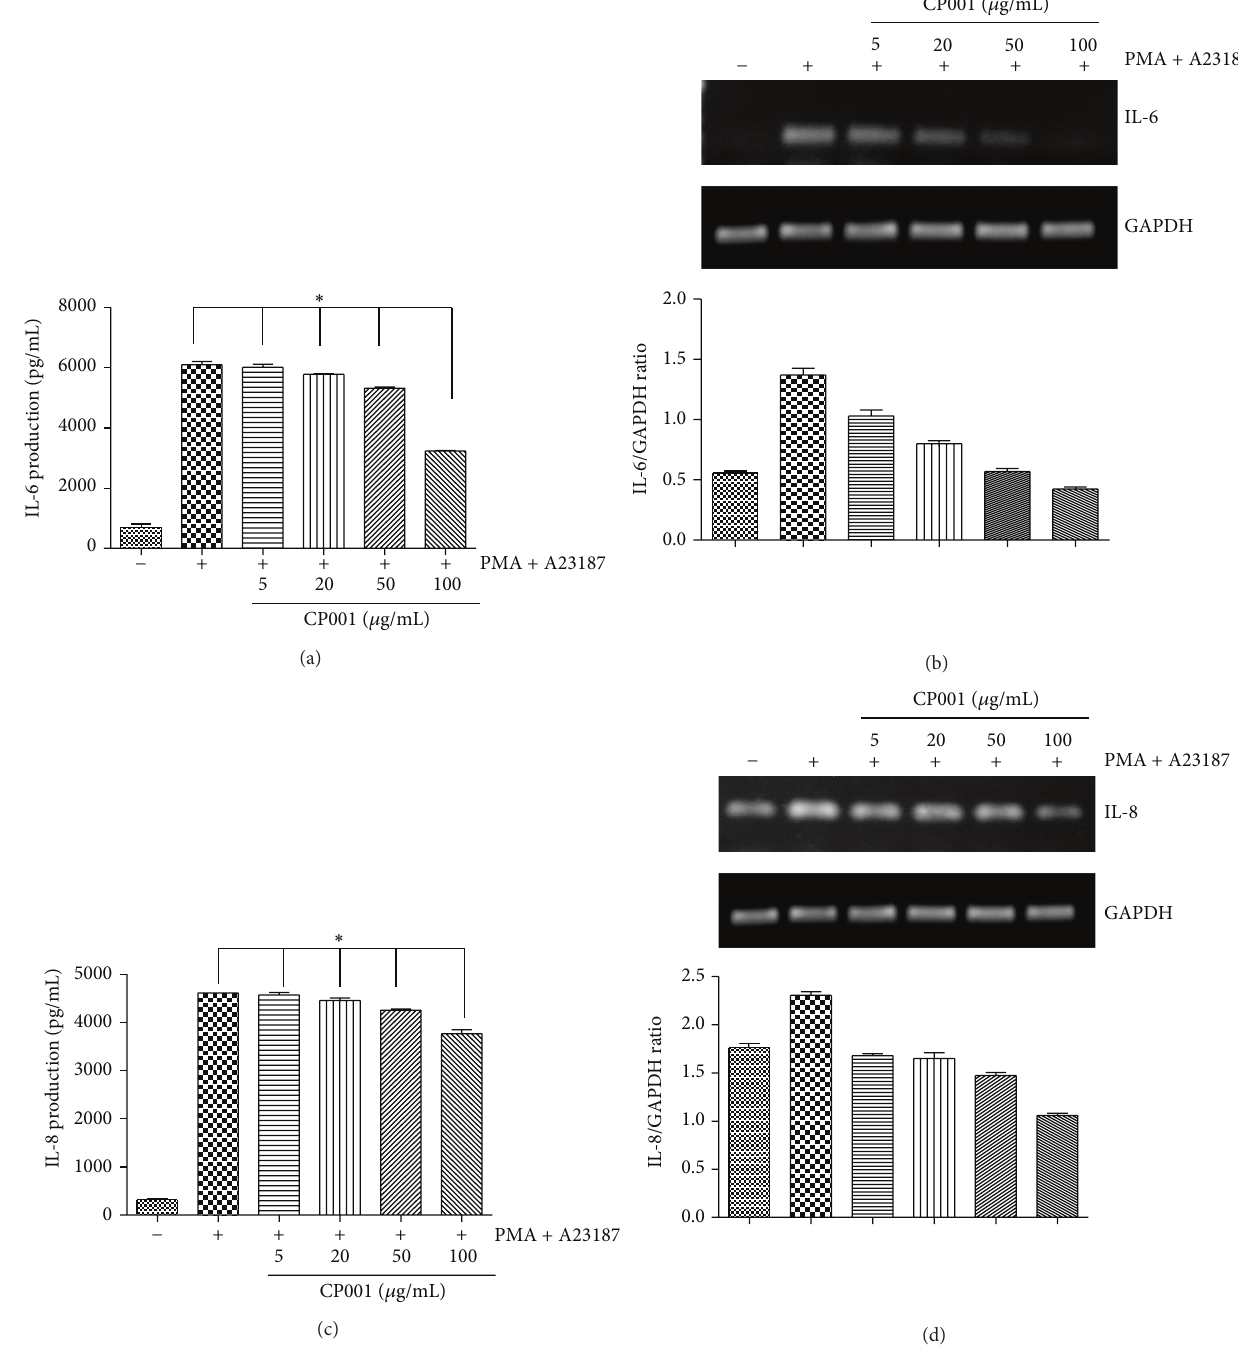
Figure 6: Effect of CP001 on PMA plus A23187-stimulated proinflammatory cytokine expression in HMC-1. HMC-1 were pretreated with various concentrations of CP001 for 1h and then treated with PMA and A23187 for 24 h. The levels of IL-6 and IL-8 in culture supernatants were measured by ELISA assay (a), (c). The IL-6 and IL-8 mRNA levels were measured by RT-PCR (b), (d). Data represent the mean ± SEMs of three independent